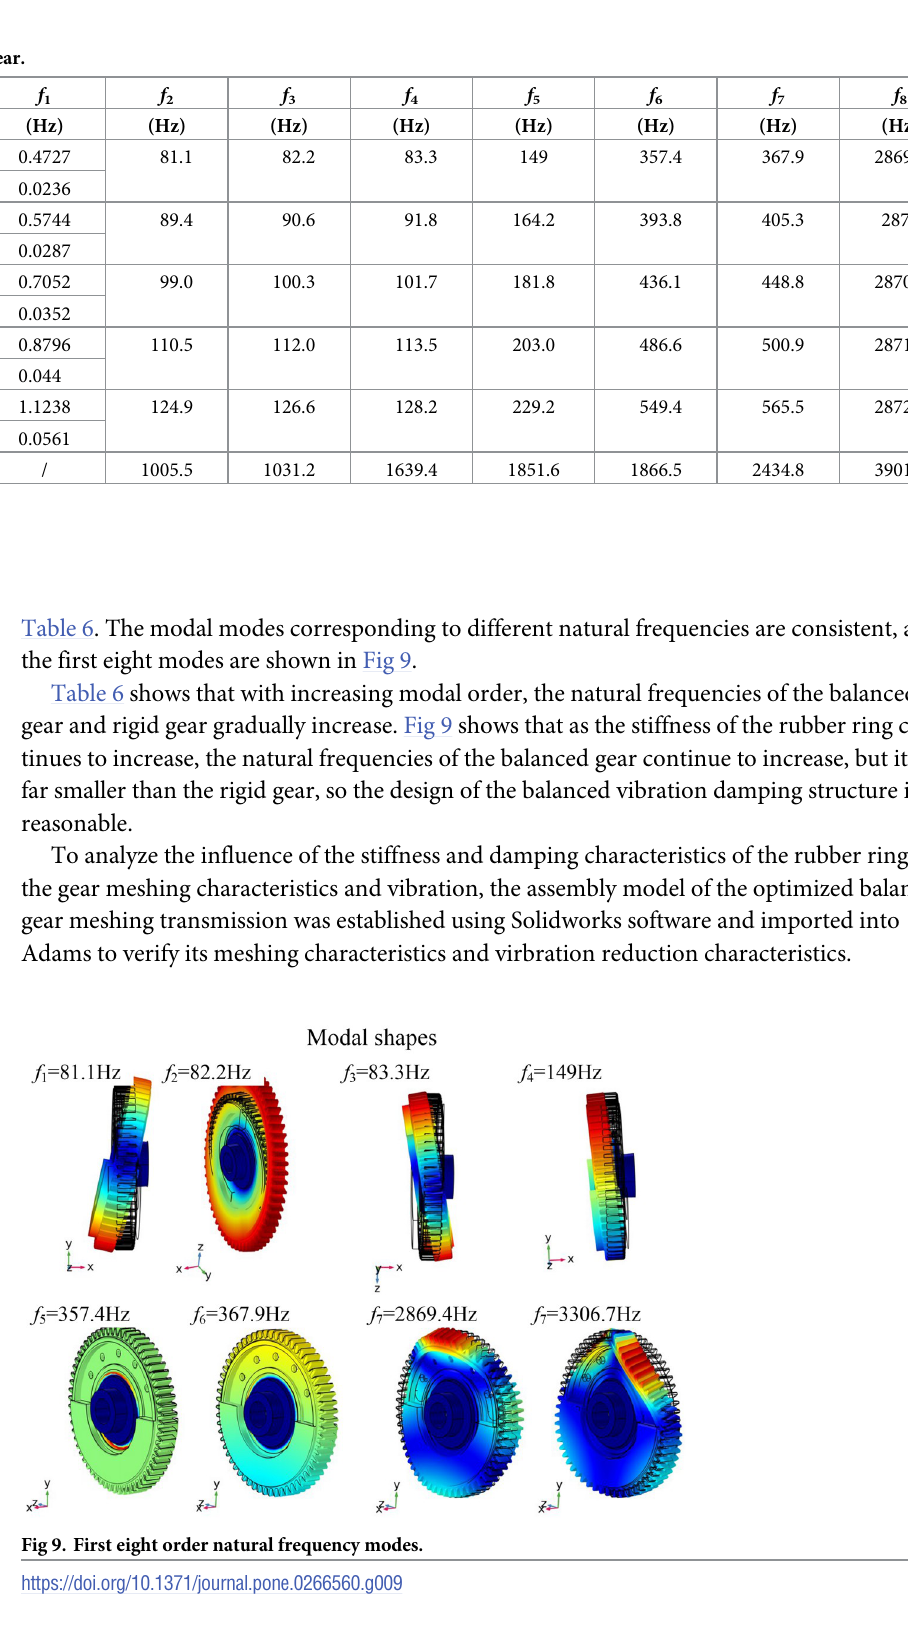
Fig 9. First eight order natural frequency